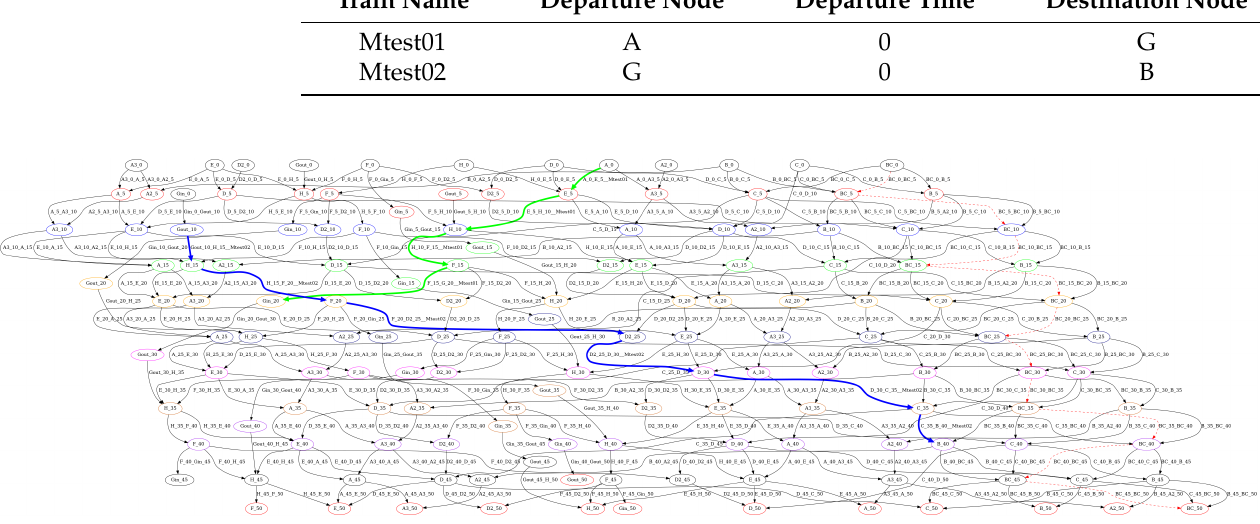
Figure 9. Case 2: Train